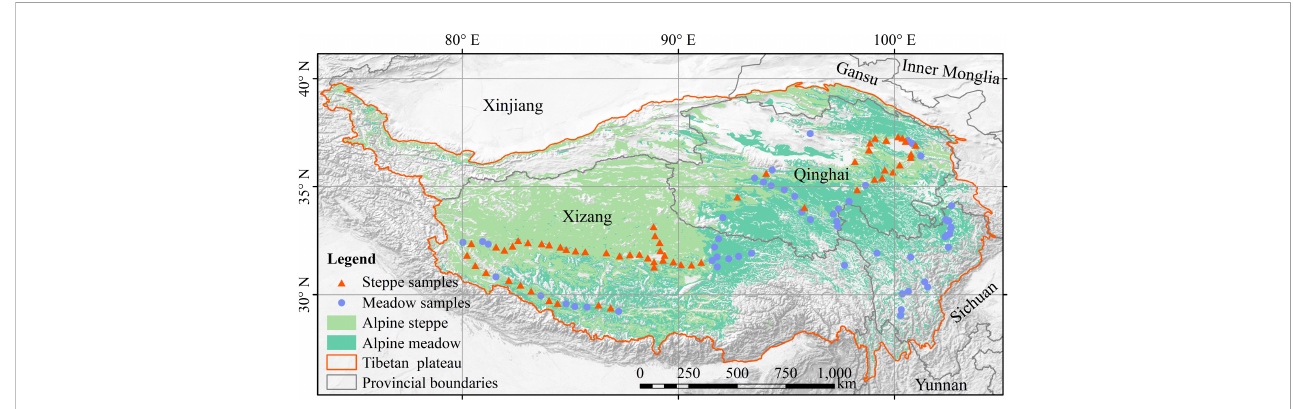
FIGURE 1 Locations and landscape of the sampling sites across the Tibetan